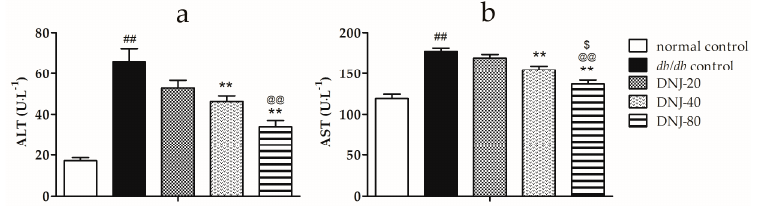
Figure 3. Effects of DNJ on activities of serum alanine aminotransferase (ALT) ( a ) and aspartate transaminase (AST) ( b ) in db / db mice. ## p < 0.01 vs. normal control. ** p < 0.01 vs. db/db control, @@ p < 0.01 vs. DNJ-20, $ p < 0.05 vs. DNJ-40 ( n = 6).